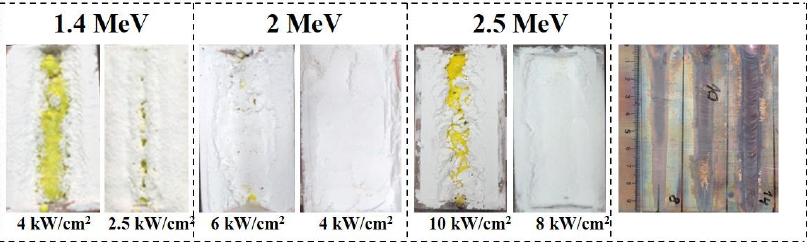
Figure 3. Photographs of ceramic samples synthesized under the exposure to electron fluxes with E = 1.4 MeV (P = 4 and 2.5 kW/cm 2 ), E = 2.0 MeV (P = 6 and 4 kW/cm 2 ), and E = 2.5 MeV (P = 10 and 8 kW/cm 2 ), and traces of the impact of electron flows with E = 1.4 MeV (P = 8, 10, 14 kW/cm 2 ) on the copper